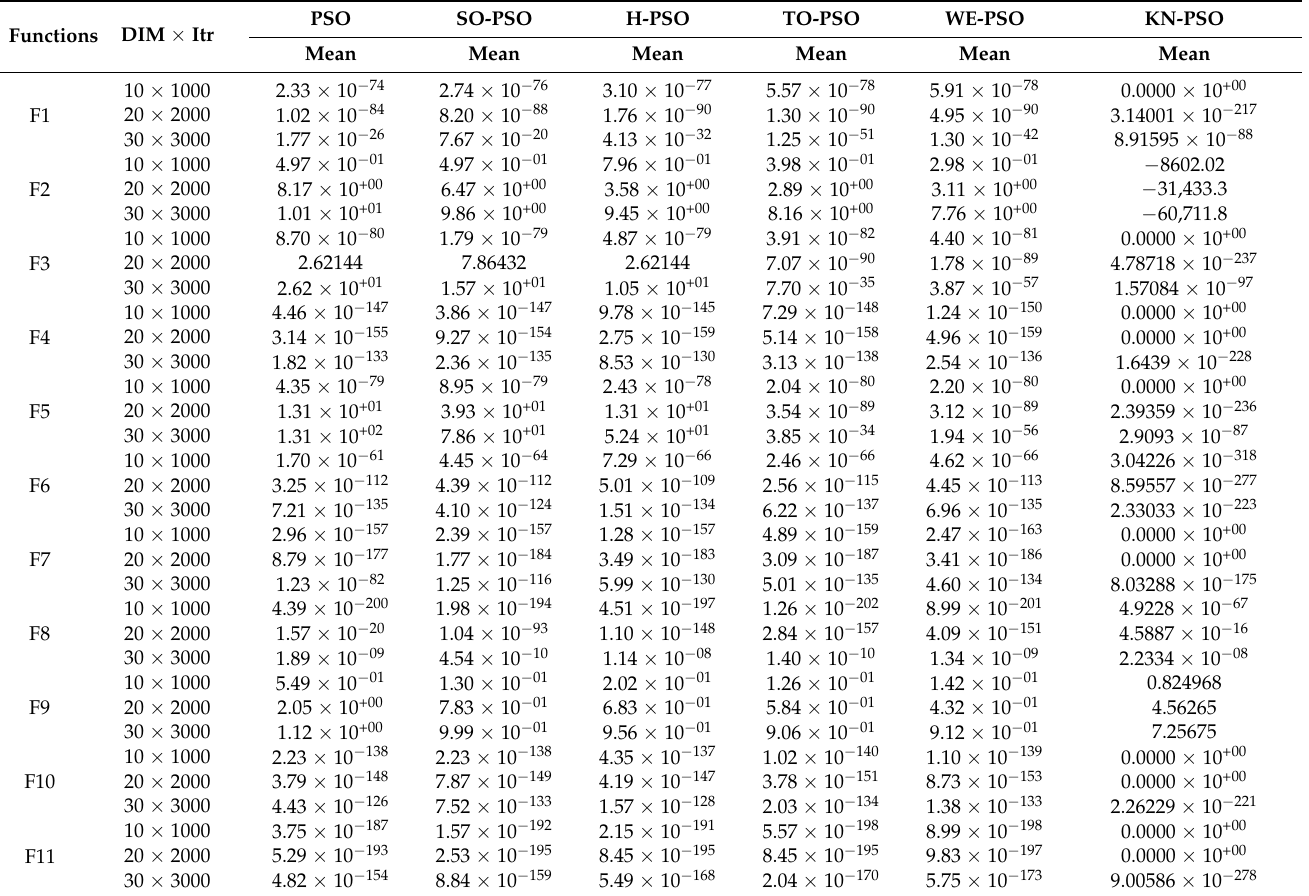
Table 4. Comparative results for all PSO-based approaches on 16 standard benchmark